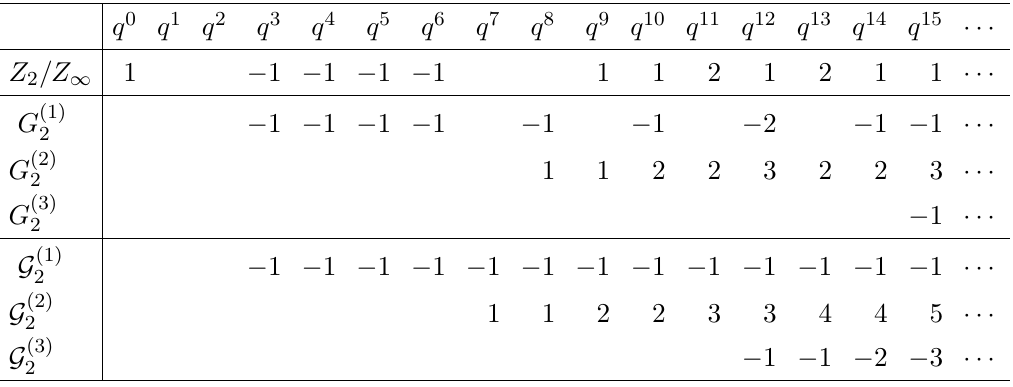
Table 1 . The 1/2 BPS index for N = 2 and the giant graviton expansion with G ( m ) Here we also present the alternate expansion in terms of G ( m )